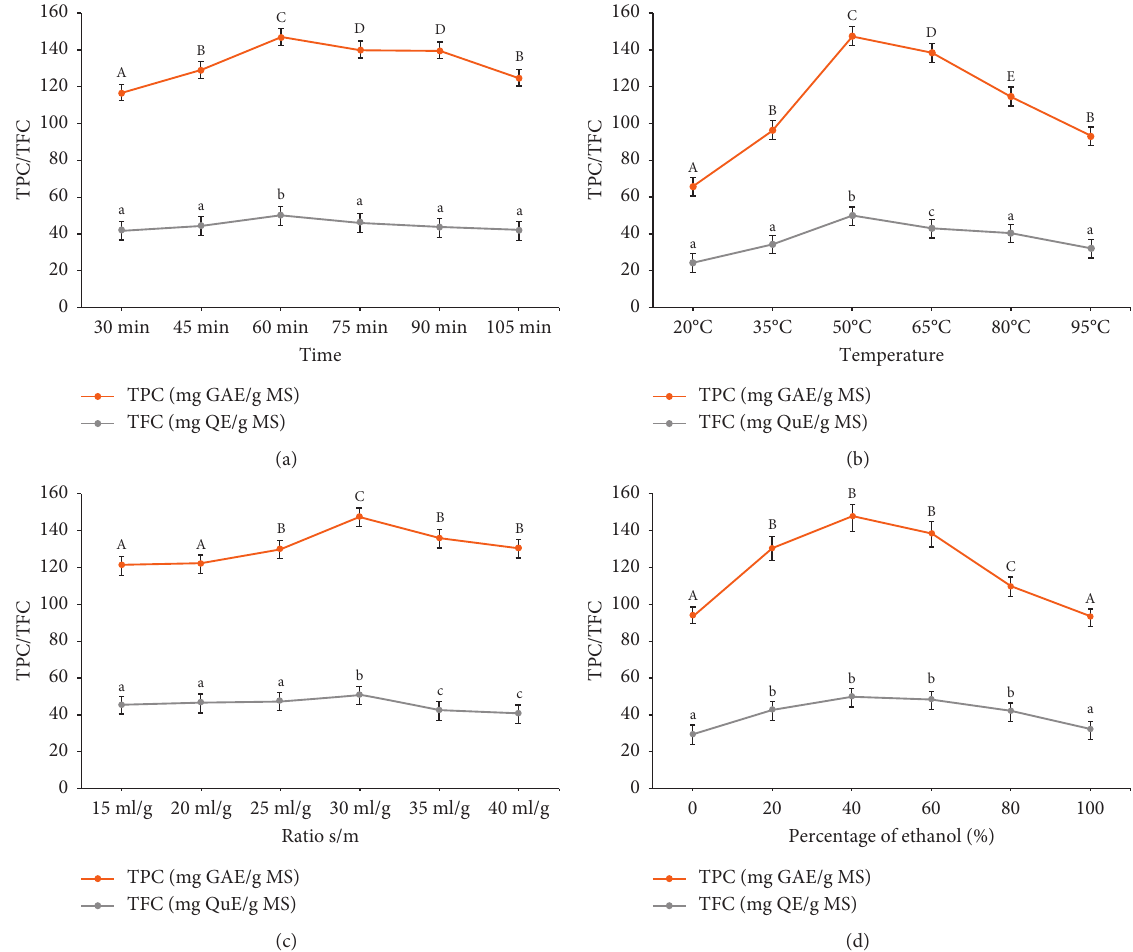
Figure 1: Effect of extraction time (a), temperature (b), ratio s/m (c), and ethanol (%) (d) on total phenol and flavonoid contents from Eucalyptus marginata L. leaves using the maceration extraction